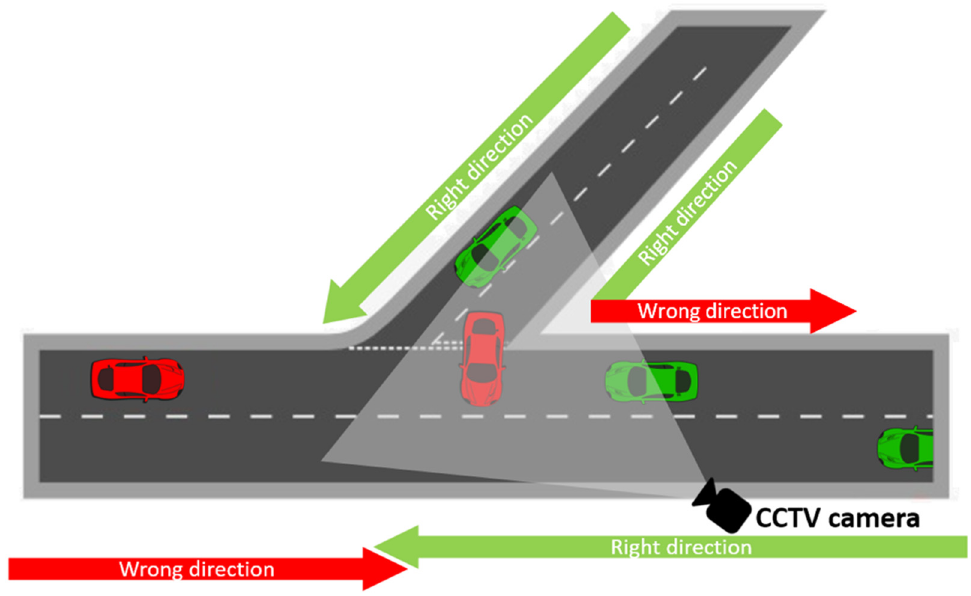
Figure 1. Wrong-direction detection scenario (triangle represents camera’s visible region).